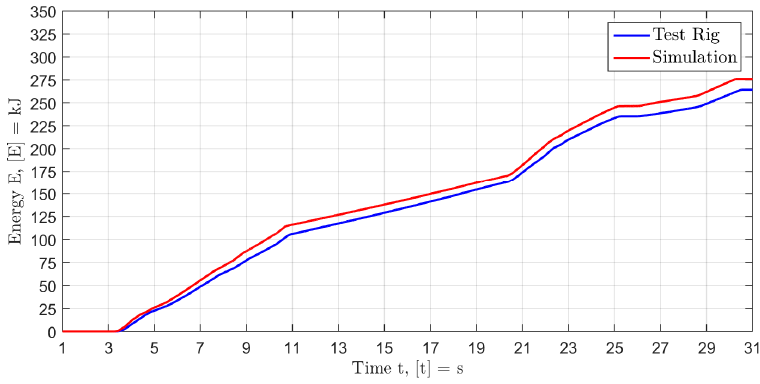
Figure 17. Energy input E S,Sum of the test rig LS system [9]. Reproduced with permission from Figure 17. Energy input (cid:1831) (cid:2903),(cid:2903)(cid:2931)(cid:2923) of the test rig LS system [9]. Reproduced with permission from the publisher. the publisher. Figure 17. Energy input (cid:1831) (cid:2903),(cid:2903)(cid:2931)(cid:2923) of the test rig LS system [9]. Reproduced with permission from the publisher.